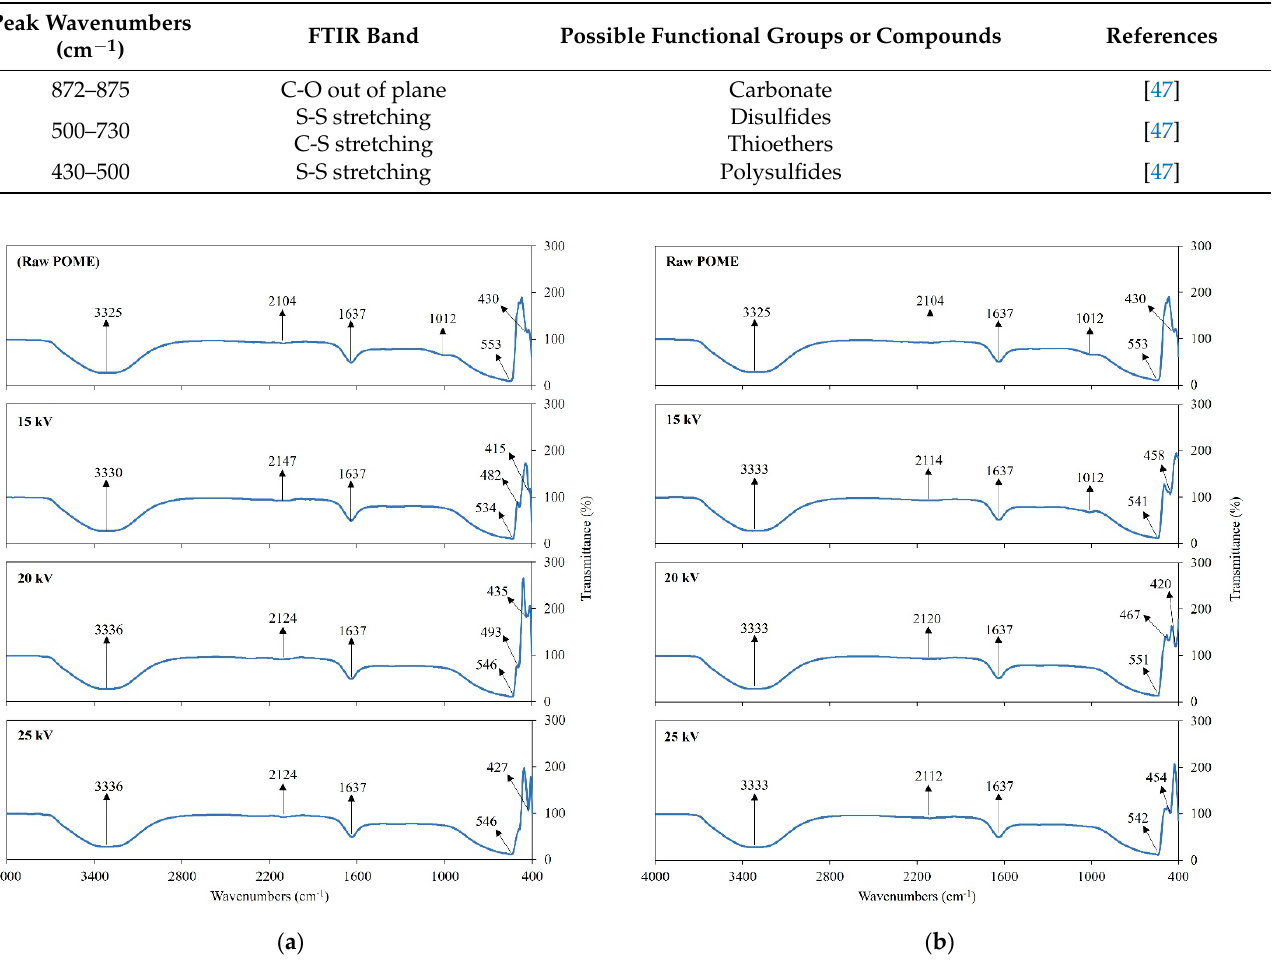
Figure 5. FTIR spectra of raw POME and POME after DBD treatment under ( a ) aerated and ( b ) non-aerated conditions at different discharge voltages of 15, 20, and 25 kV. Table 5. FTIR frequency ranges and functional groups in raw POME and POME after DBD treatment under non-aerated and aerated conditions.